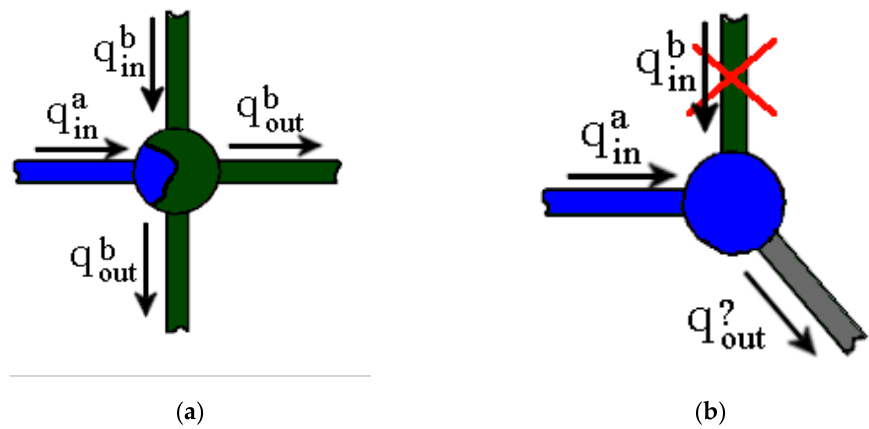
Figure 4. The simultaneous inflow of two flows with different fluids into the pore ; ( a ) pore is not filled; ( b ) pore is filled. Colors: green — oil, blue — displaced fluid.